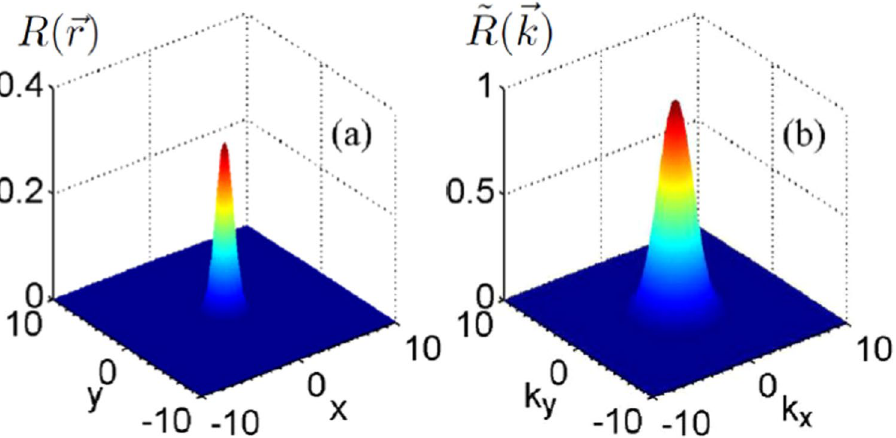
Figure 1. The profile of the Gaussian nonlocal response function ( a ) and its Fourier transform in ( b